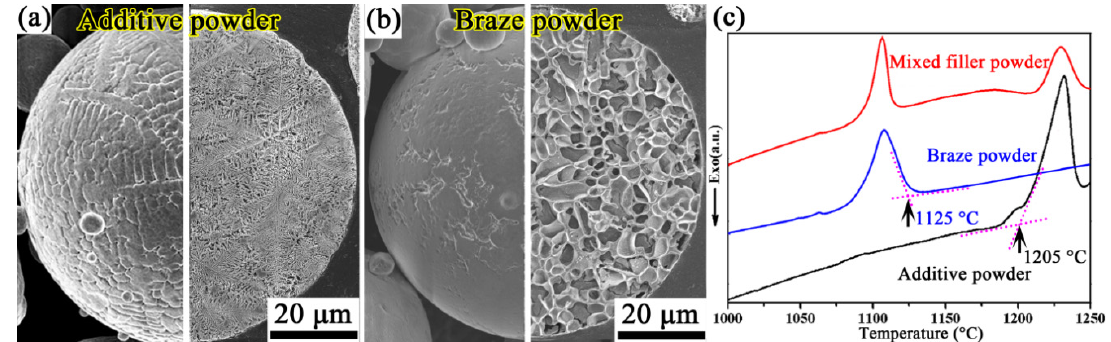
Figure 1. Micrographs of surface morphology and corresponding cross-section of the additive powder ( a ) and braze powder ( b ), and DSC curves of the additive powder, braze powder and mixed filler powder ( c ) (note, the cross-section of the additive powder and braze powder was etched by the prepared corrosion solution (20 g anhydrous CuSO 4 + 100 mL HCl + 5 mL H 2 SO 4 + 10 mL H 2 O) for 40 s).